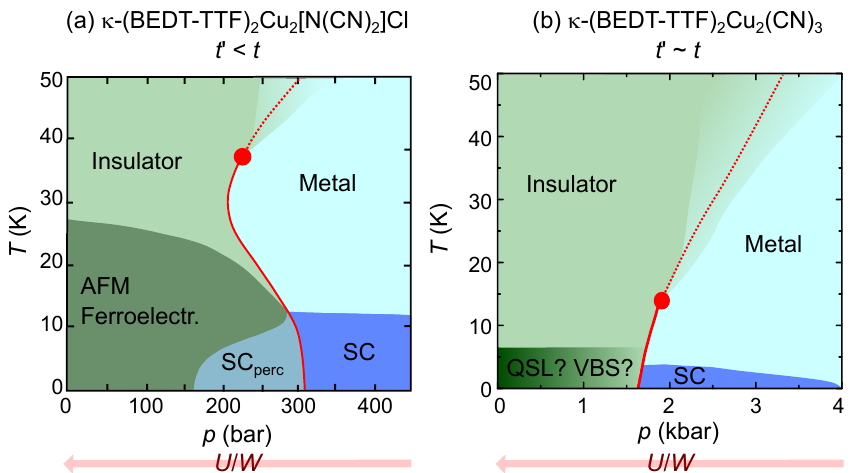
Figure 3. Experimental temperature–pressure phase diagrams of κ -phase charge-transfer salts: ( a ) κ -(BEDT-TTF) 2 Cu[N(CN) 2 ]Cl (‘ κ -Cl’) [1,3,4,9,16,21,22] and ( b ) κ -(BEDT-TTF) 2 Cu 2 (CN) 3 (‘ κ - CuCN’) [7,10,23,34]. At ambient pressure and low-enough temperatures, both compounds exhibit a Mott insulating ground state (i.e., a moderate to large correlation strength, U / W ). Upon applying pressure, U / W is reduced and eventually a first-order Mott metal-insulator transition is induced (red line) which ends in a second-order critical endpoint (red circle). On both sides of the Mott transition, intriguing electronic orders emerge at lowest temperatures. On the Mott insulating side, κ -Cl orders antiferromagnetically [35], which is well-understood given the anisotropy of its triangular lattice ( t (cid:48) < t ). The antiferromagnetic (AFM) order is believed to be accompanied by the emergence of long-range ferroelectric order, making this compound multiferroic [16]. In contrast, κ -CuCN is characterized by an almost isotropic triangular lattice with t (cid:48) ∼ t . For a long time, it has, therefore, been considered as a candidate for quantum spin-liquid (QSL) behavior [10]. However, there exist recent results which argue in favor of the formation of a valence bond solid (VBS) [12,13,34,36–38]. On the metallic side of the Mott transition, both compounds exhibit superconductivity (SC). A region of percolative superconductivity SC perc can also be found in the Mott insulating state close to the metal-insulator